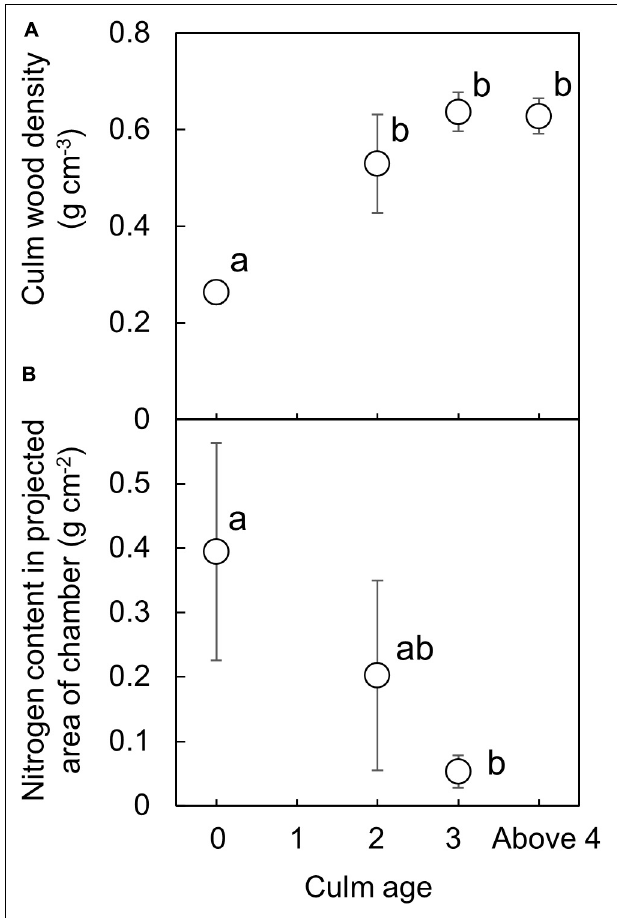
FIGURE 3 | Age variation of culm wood density (A) and nitrogen content in projected chamber area (B) . Data was obtained using culm samples taken on the harvesting day in June. Culm wood density increased with culm age, and more than doubled in two years (A) . Nitrogen content (g/projected chamber area) in the culm tissue decreased with age (B) . The same letter indicates no significant difference with ages ( p > 0.05, Tukey’s post ANOVA